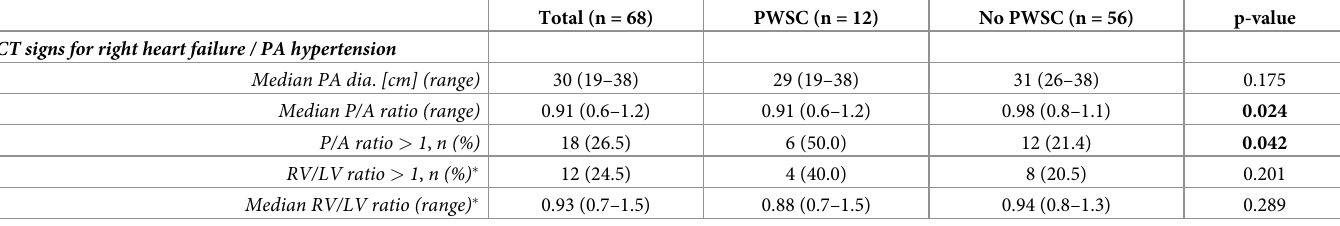
Table 4. Imaging findings in the COVID-19-cohort–CT signs for right heart failure/pulmonary artery hypertension. Peripheral wedge-shaped consolidation (PWSC) as imaging biomarker for microinfarction, number of cases (n), pulmonary artery (PA), diameter (dia.), pulmonary artery aorta ratio (P/A ratio), right/left ven- tricular ratio (RV/LV ratio).